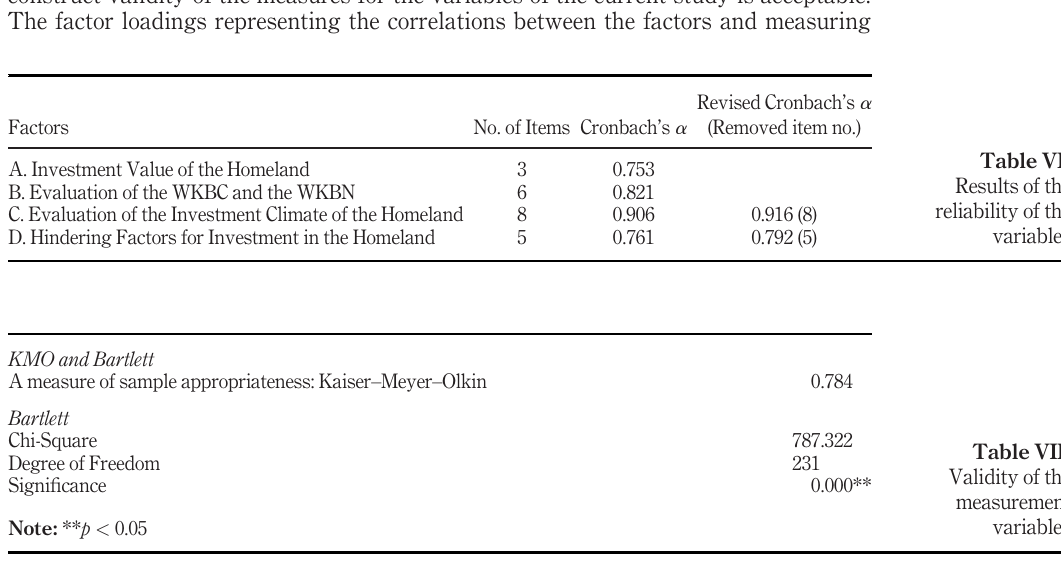
Table VIII: Evaluation of the WKBC (B-1) and Evaluation of the WKBN (B-2). The OKF